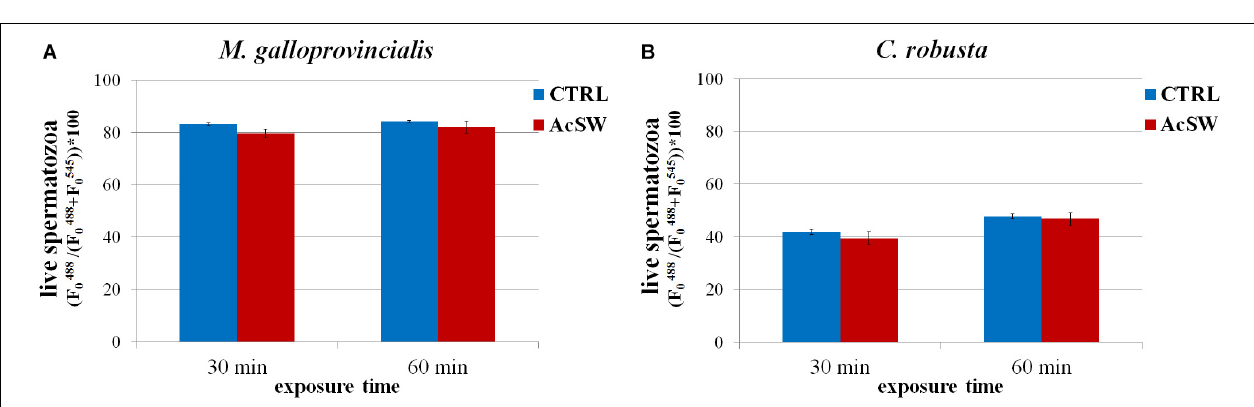
FIGURE 5 | Effect of acidified seawater (AcSW) on intracellular pH of M. galloprovincialis (A) and C. robusta (B) spermatozoa (mean ± SE). pH i was evaluated by using the probe BCECF-AM after sperm exposure for 30 and 60 min to filtered natural seawater with a pH value of 8.1 (CTRL) and to AcSW with a pH value of 7.8. ∗ indicates significant ( P ≤ 0.05) differences.